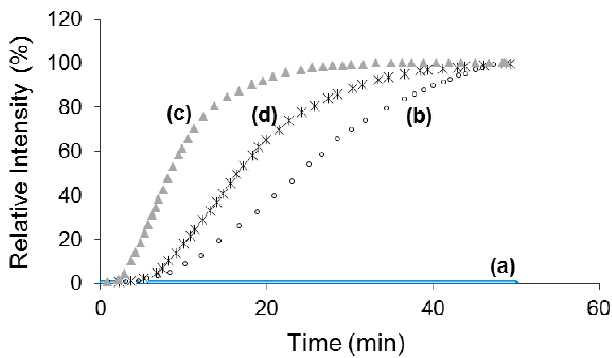
Figure 6. Transmitted light intensity during the isothermal crystallization at 135 °C for ( a ) iPP wax and wax–sorbitol compounds; ( b ) DBS, ( c ) MDBS, and ( d ) DMDBS.